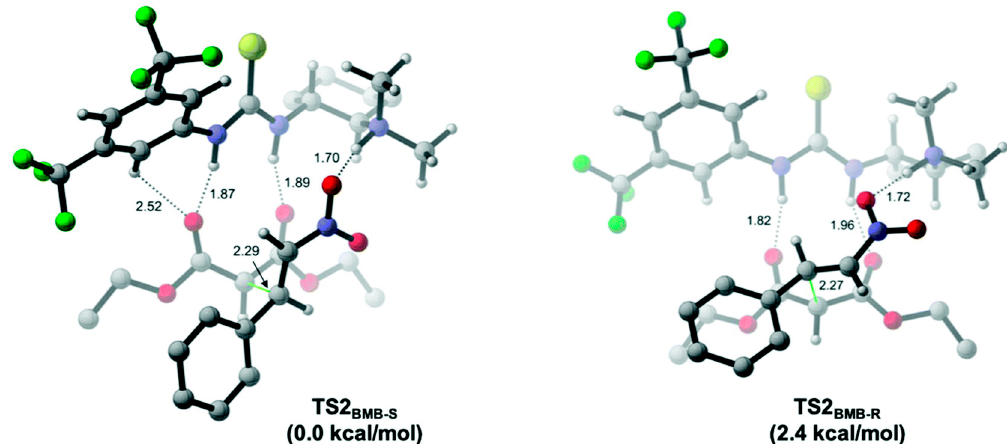
Figure 6. Lowest energy transition structures for the Michael addition of 1a to 2a catalyzed by C1 . Reprinted and adapted from Organic and Biomolecular Chemistry with permission from Royal Society of Chemistry [25].